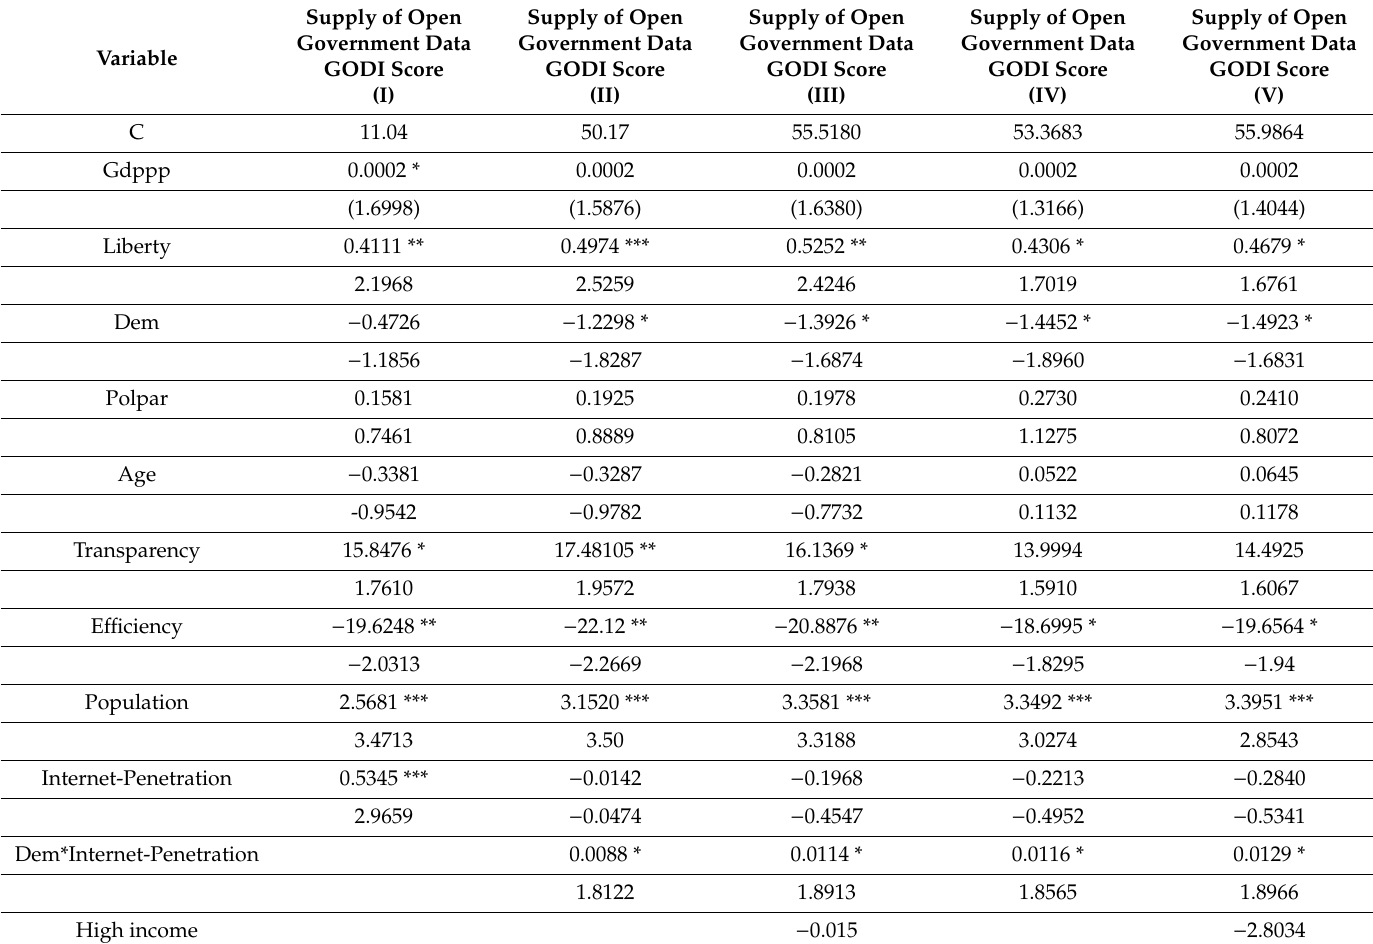
Table 1. Results of OLS estimators with heteroscedasticity-consistent standard